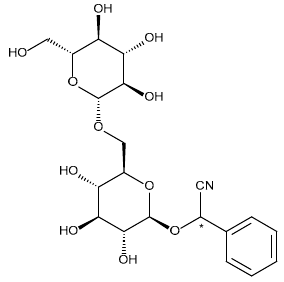
Figure 1. Amygdalin structural